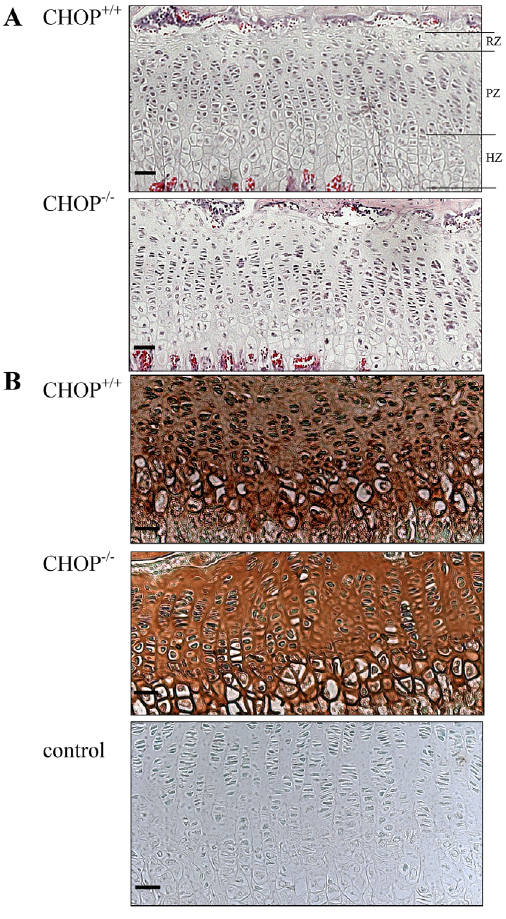
Figure 2. Histochemical analysis of growth plate cartilage. A ) Haematoxylin and eosin staining of wild type and CHOP null growth plates at 3 weeks of age showing normal columnar organisation of chondrocytes in the growth plates of both genotypes and delineating the resting (RZ), proliferating (PZ) and hypertrophic (HZ) zones of the growth plate. B ) Immunohistochemistry for COMP showing the normal distribution of COMP in wild type and CHOP null growth plate at 3 weeks of age. The negative control was generated using the secondary antibody only. Key: RZ=resting zone; PZ=proliferative zone; HZ=hy- pertrophic zone; CHOP + / + =wild type, CHOP 2 / 2 =knock-out. Scale bar for all images is 100 m m.